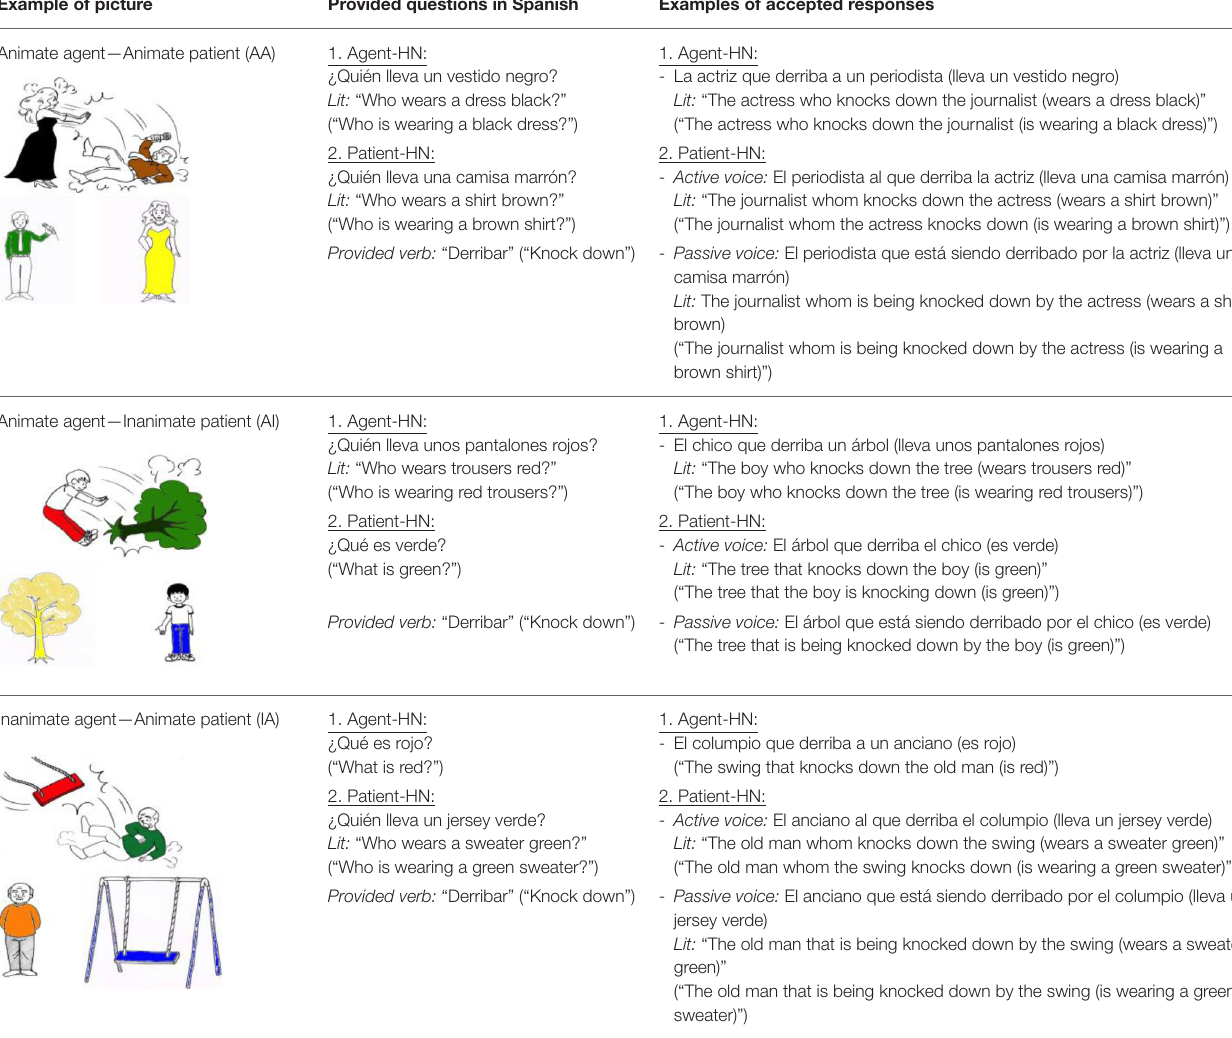
TABLE 2 | Examples of critical items in the three animacy conditions with provided questions and examples of accepted responses in Spanish. Example of